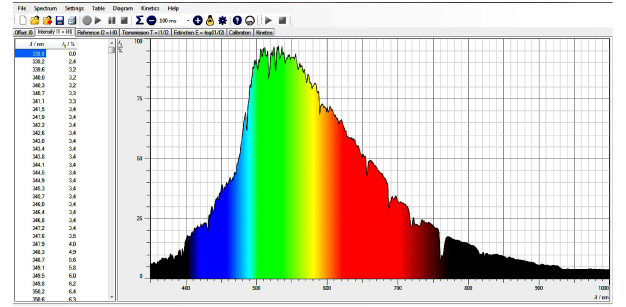
FIG. 11. Sun ’ s spectrum measured through a spectrometer. The spectrum is not calibrated in